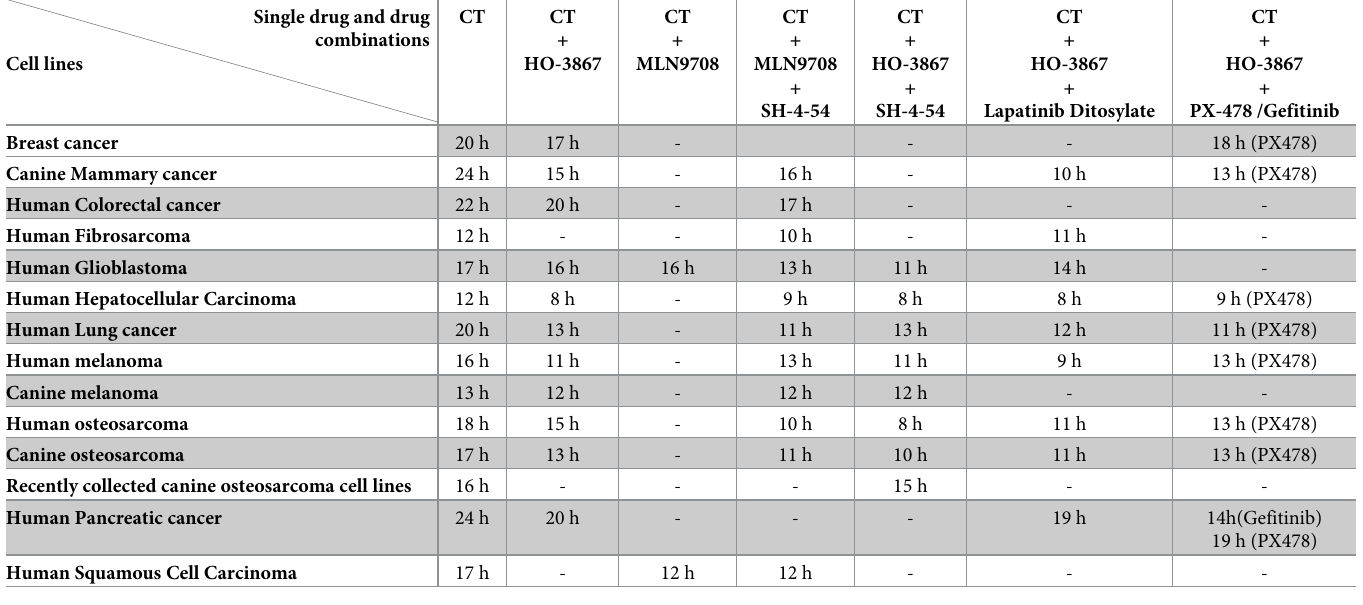
Table 1. Time response in hours (h) to cell death induced by single drug and drug combinations screening in different human and canine cancer cell lines using a live-cell imaging-based assay. Single drug and drug combinations